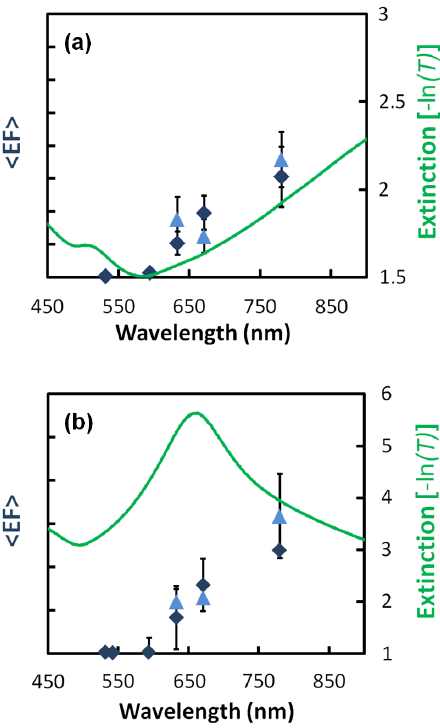
FIG. 2. Graphs comparing the observed SERS enhancement factor h EF i and optical extinction [ (cid:1) ln ð T Þ ] for the case of (a) 120-nm-long nanorods with average diameter 48 nm at 0 (cid:2) incidence and (b) 350-nm-long nanorods with average diameter 38 nm at 40 (cid:2) incidence (in both cases in the array, the period is 65 nm). The green lines indicate the optical extinction. Black- diamond and blue-triangle data points indicate the h EF i of the 915 - cm (cid:1) 1 band of CV and the 775 - cm (cid:1) 1 band of R6G, respec- tively. The scale on the h EF i axis is the same on both graphs. Enhancement factors are plotted at the excitation